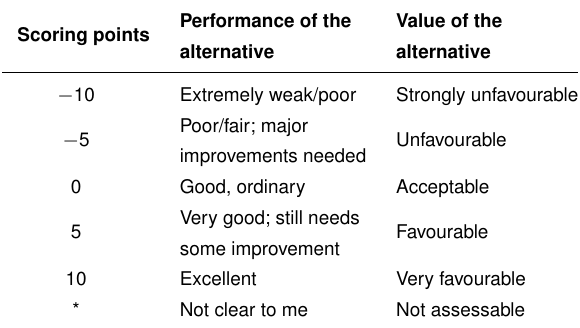
Table 4. The scoring system applied in the